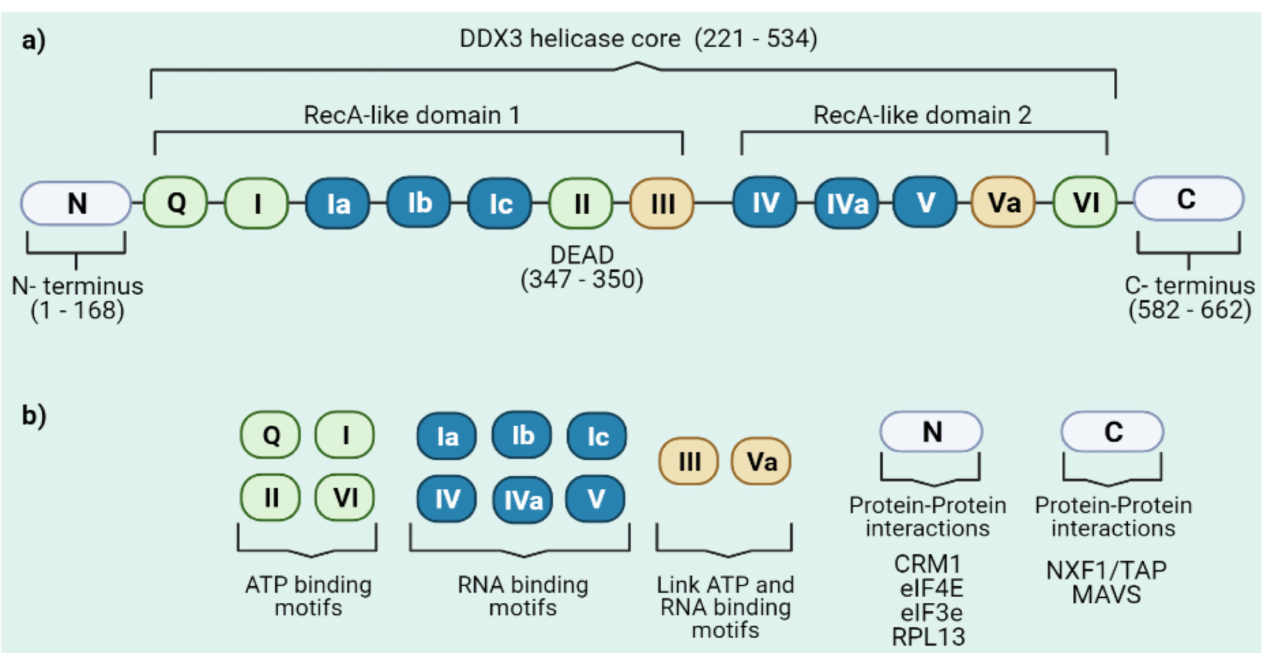
Figure 1. DEAD-box RNA helicase DDX3. ( a ) Schematic representation of the DDX3 organization showing the variable N- and C- terminal domains and the conserved helicase core. The catalytic core consists of two RecA like domains which contain functional motifs. ( b ) Distinct functions of DDX3 motifs. While motifs Q, I, II and VI are involved in ATP binding, motifs Ia, Ib, Ic, IV, IVa and V are involved in RNA binding. Also, motifs III and Va are related to the linking of ATP hydrolysis and double strand unwinding. Finally, DDX3 N - and C -terminal domains participate in some protein-protein interactions with proteins involved in mRNA metabolism or innate immune